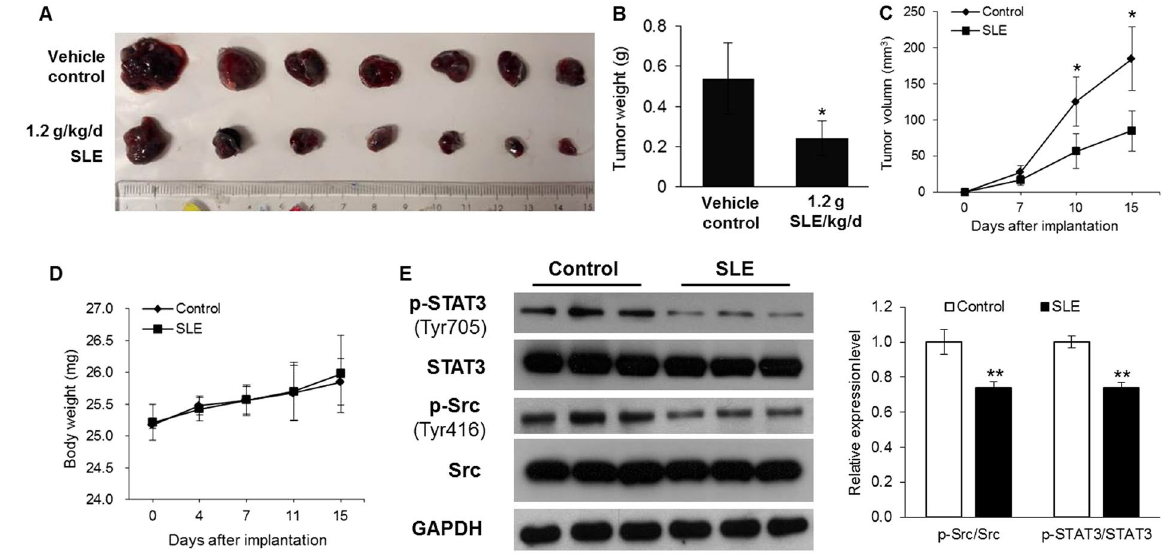
Figure 1. Anti-melanoma effects of SLE in mice. ( A ) The photo of B16F10 tumors dissected from mice. ( B ) Mean weights of the dissected tumors. ( C ) Time-dependent effect of SLE on melanoma growth in a B16F10 allograft mouse model. ( D ) Body weights at different time points. In ( B ), ( C ) and ( D ), data were means ± SD of 7 mice. ( E ) Protein expression levels of phospho-STAT3 (Tyr705), STAT3, phospho-Src (Tyr416), Src and GAPDH in B16F10 tumors collected from 3 individual mice were examined by immunoblotting (left panel) and the relative band intensity was analyzed by Image J software (right panel). The images shown were the cropped blots for the corresponding proteins. The original blots from which images were cropped were shown in Supplementary Dataset. * P < 0.05, ** P < 0.01 versus vehicle control